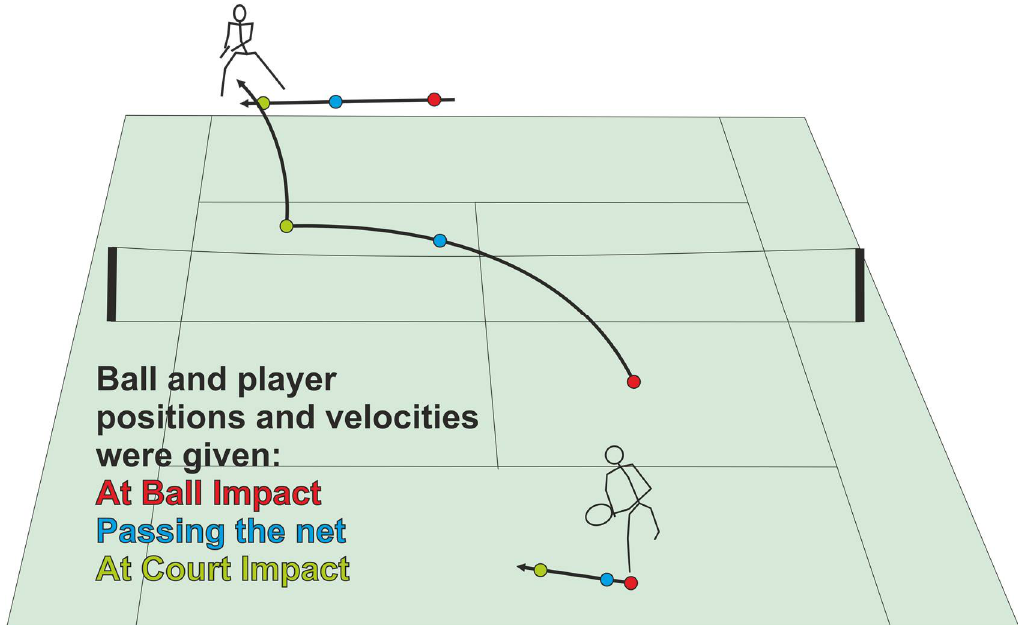
Figure 1. The Hawk-Eye system provided positions and velocities of ball and player at three distinct points: ball impact, passing the net and court